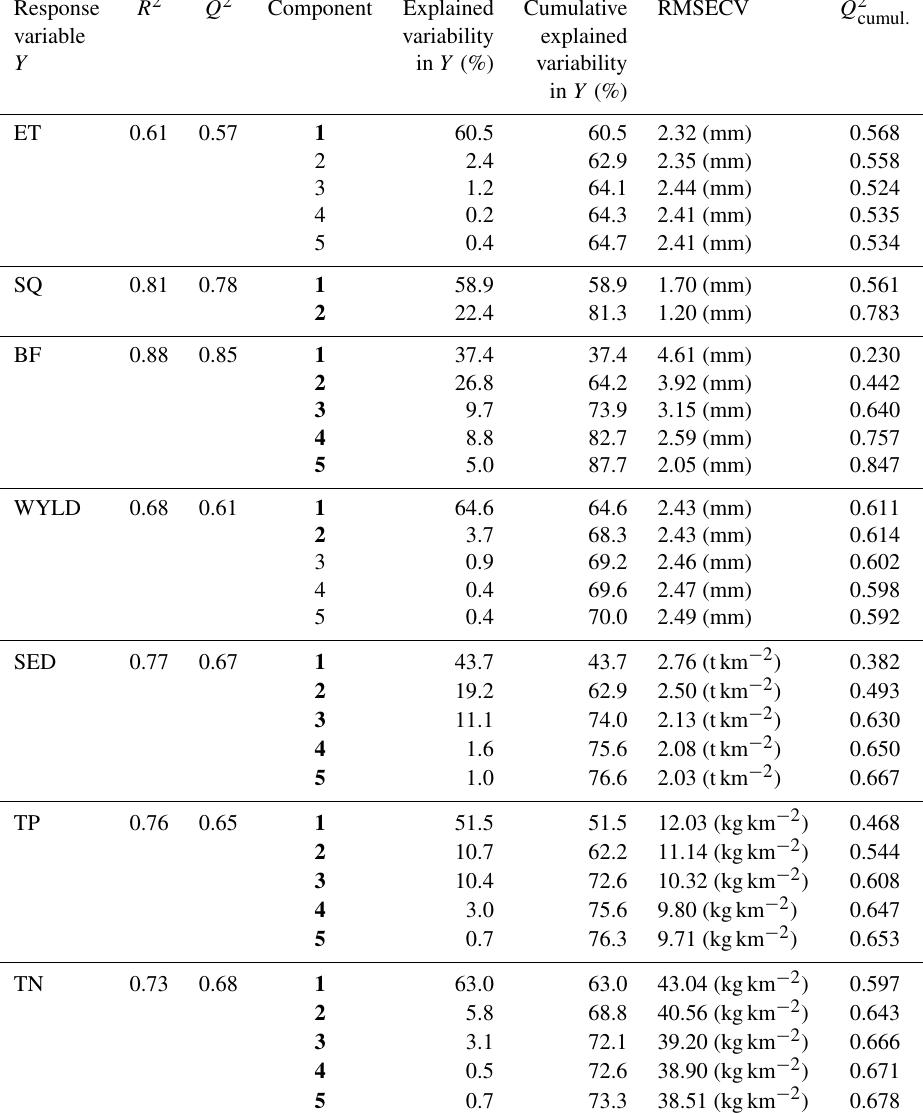
Table 4. Summary of the PLSR models of evapotranspiration (ET), surface runoff (SQ), base flow (BF), water yield (WYLD), sediment yield (SED), total phosphorus load (TP), and total nitrogen load (TN) at the subbasin scale.